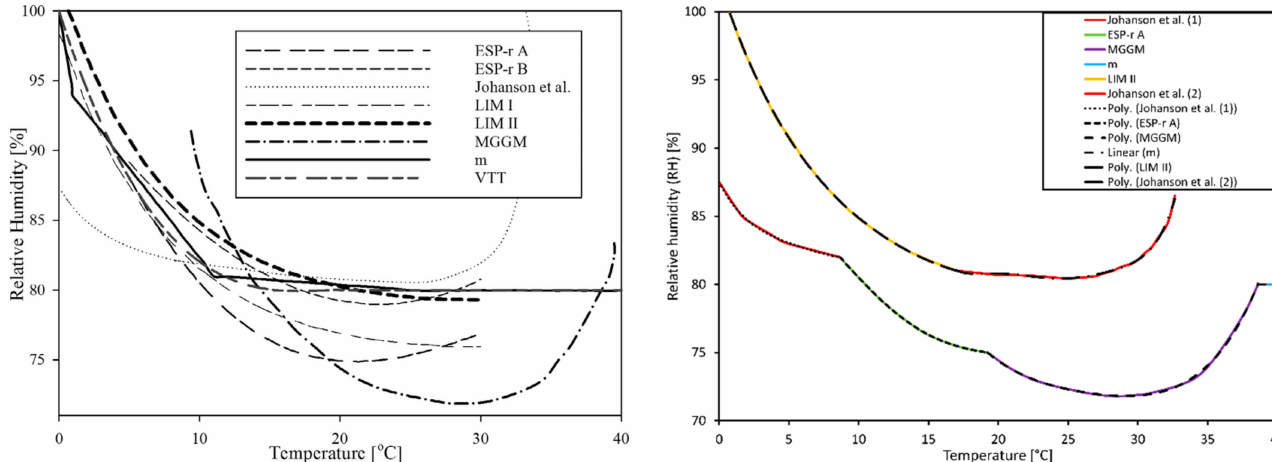
Figure 7. Adaptation ( right ) of different criteria graphs for the onset of mould growth, collected by Gradeci et al. [16] ( left ). Original image used with permission. Note that the numbers (1) and (2) in the legend refer to different parts of the same curve seen in the left-side image, that correspond to the upper or lower graph depending on temperature range.